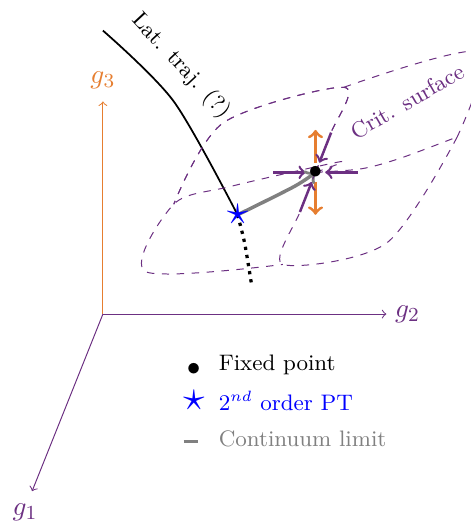
Figure 1 . Sketch of the fixed point scenario for 5D SU(2) Yang-Mills suggested by the (cid:15) expansion. The orange (purple) arrows represent the repulsive (attractive) directions. The black line is the trajectory followed by the model when we change the lattice couplings. The dashed purple line shows the critical surface separating distinct basins of attraction. In the lattice simulations, we expect to observe a behavior change when we cross this critical